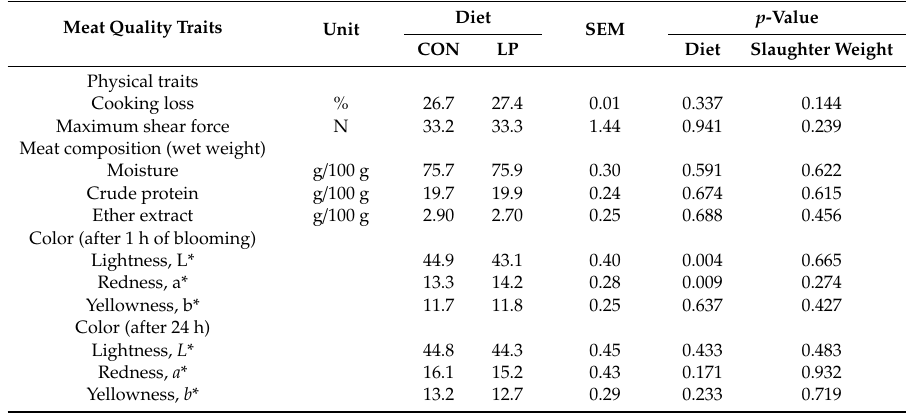
Table 8. The e ff ects of high (CON) and low (LP) protein and covariate slaughter weights on the meat quality of young Charolais beef bulls at Rovigo Province,